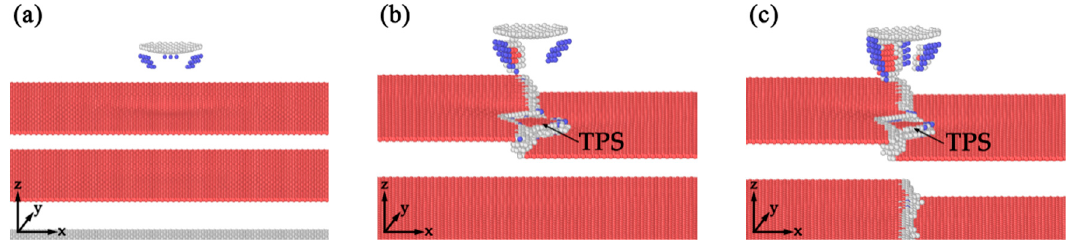
Figure 7. Atomistic configurations of three different models at indenter depth d = 4.8 Å. ( a ) TPT; ( b ) SDT; ( c ) TDT.